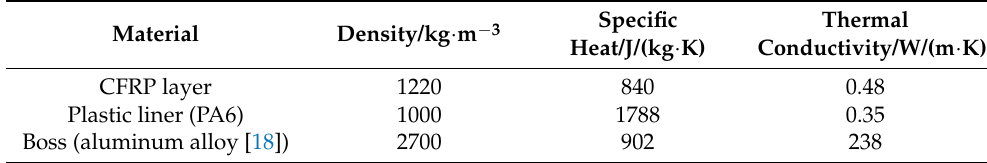
Table 3. Summary of material